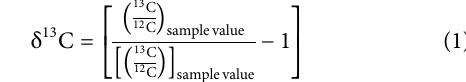
Frontiers in Earth Science |